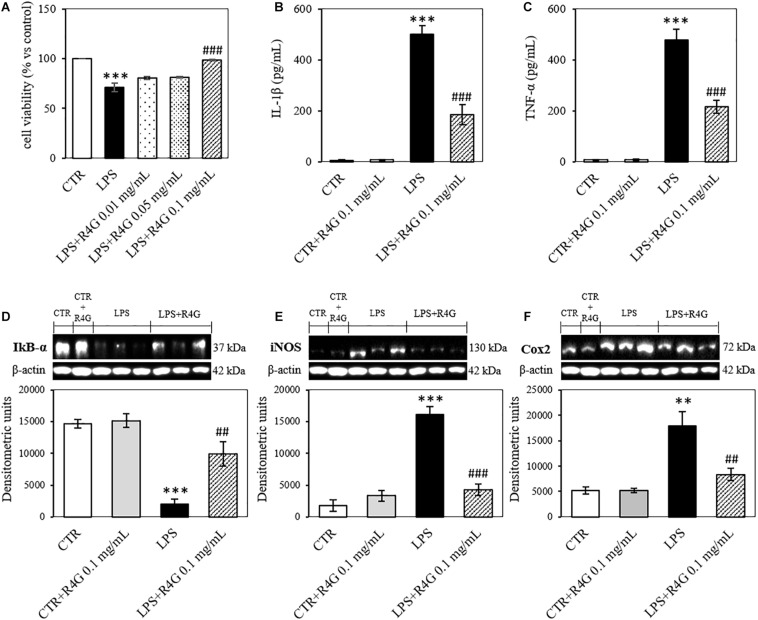
Anti-inflammatory activity of R4G in J774A.1 cells. (A) Cell viability after treatment with bacterial lipopolysaccharides (LPSs) with or without subsequent exposure to R4G extract. (B) Detection of the pro-inflammatory cytokine IL-1β in the culture supernatant. (C) Detection of the pro-inflammatory cytokine TNFα in the culture supernatant. Western blot analysis of cell lysates for the detection of (D) iNOS, (E) COX-2, and (F) IκBα. Data are means ± standard errors [n ≥ 3, ##p < 0.01; ###p < 0.001 vs. LPS; ∗∗∗p < 0.001, ∗∗p < 0.01 vs. control (CTR) based on one-way ANOVA followed by Bonferroni post hoc test]. Densitometric units = OD × mm2.